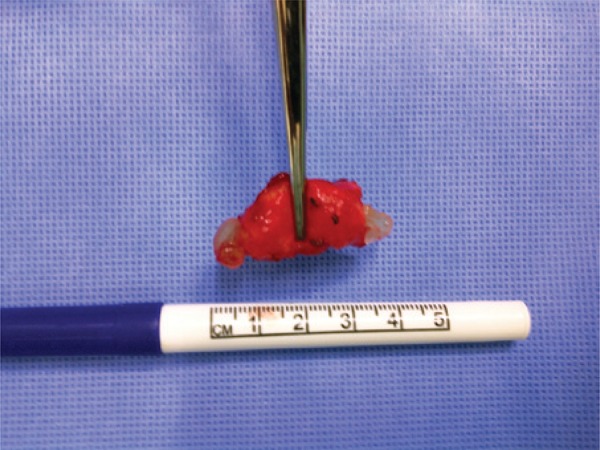
Surgical specimen